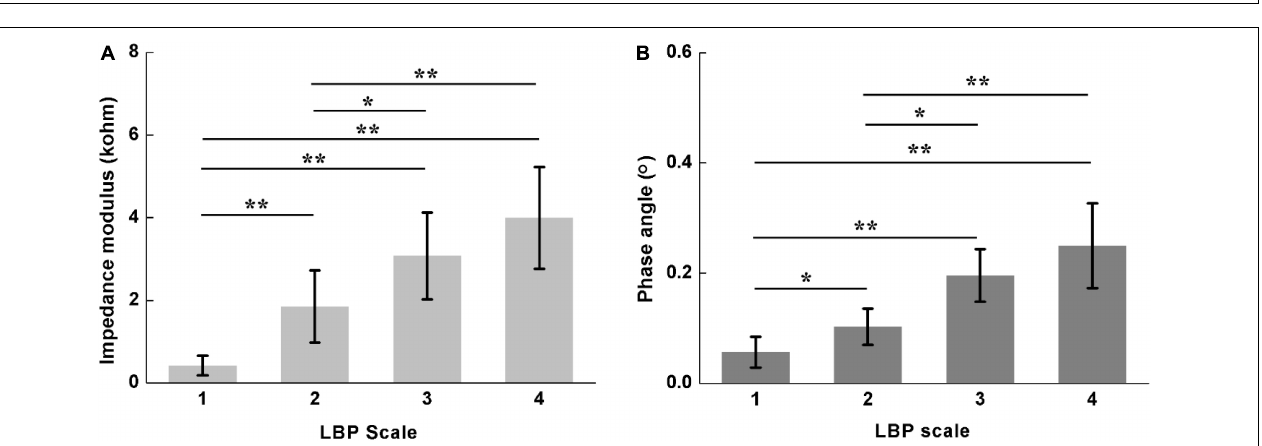
FIGURE 6 | Comparisons of difference of lumbar muscle impedance on both sides between participants with and without LBP, including (A) impedance modulus (pain: 2.59 ± 1.42; no pain: 0.42 ± 0.24) and (B) phase angle (pain: 0.10 ± 0.05; no pain: 0.11 ± 0.03). **denotes P < 0.01.